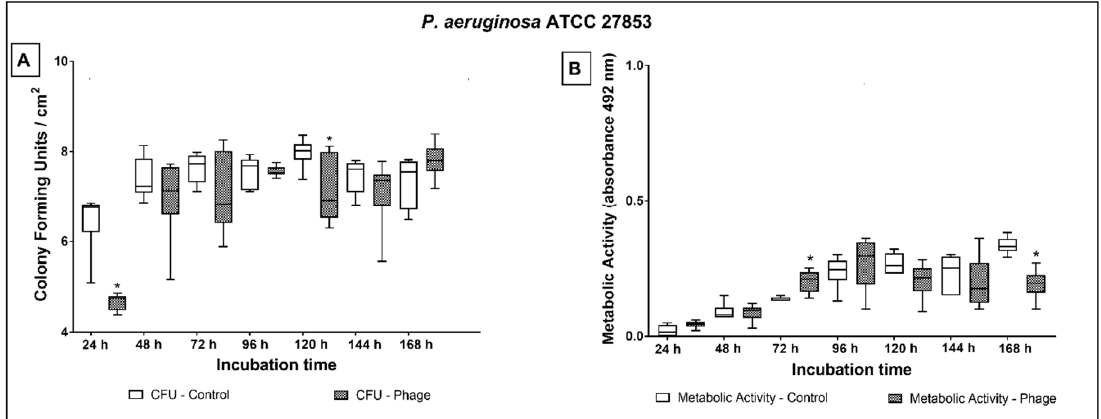
Figure 3. Biofilm growth ( A ) and metabolic activity ( B ) of P. aeruginosa ATCC 27853 over 24 to 168 h of dynamic biofilm growth on non-coated and phage cocktail-coated tubes. Comparisons were conducted among groups, at each time point, by means of multiple comparisons considering strains and phage cocktail treatment in a generalized linear model with Bonferroni correction. * indicates statistically significant difference at each time point ( p < 0.05).